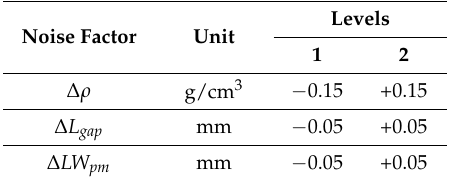
Table 7. Noise factors and levels for the FSPMM.